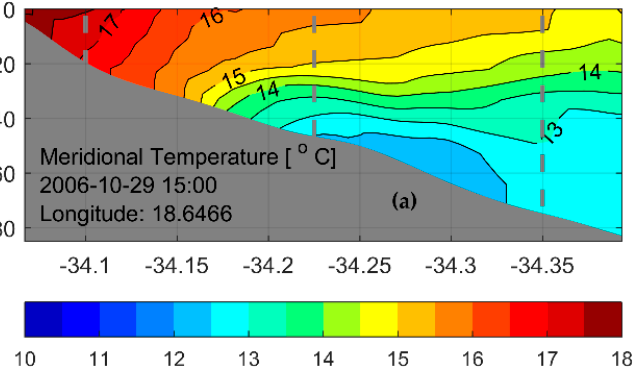
Figure 19. Transient temperature stratification in False Bay during early summer (late October).